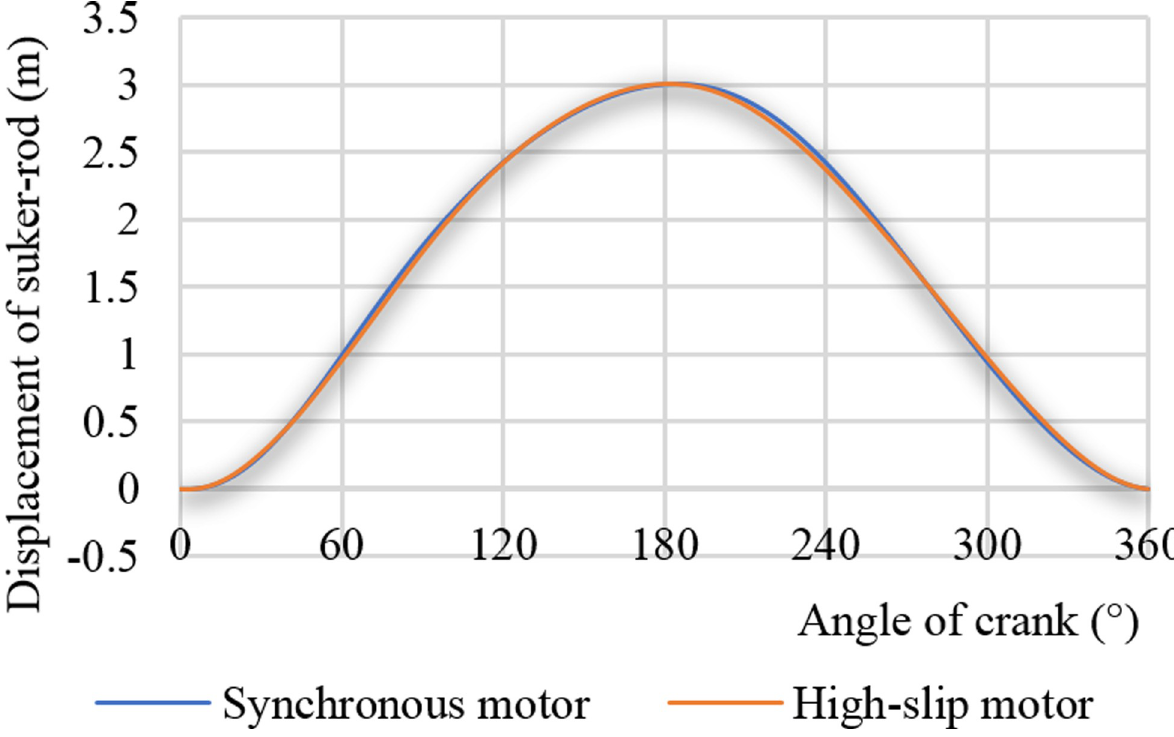
Fig 8. Displacement curves of the sucker